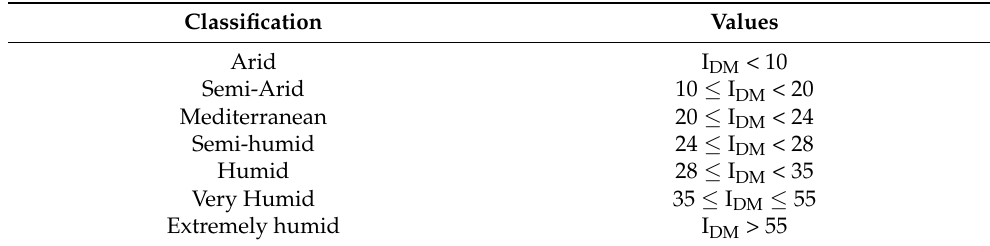
Table 1. Type of climate according to the De Martonne aridity index (I DM , adapted after Baltas, 2007